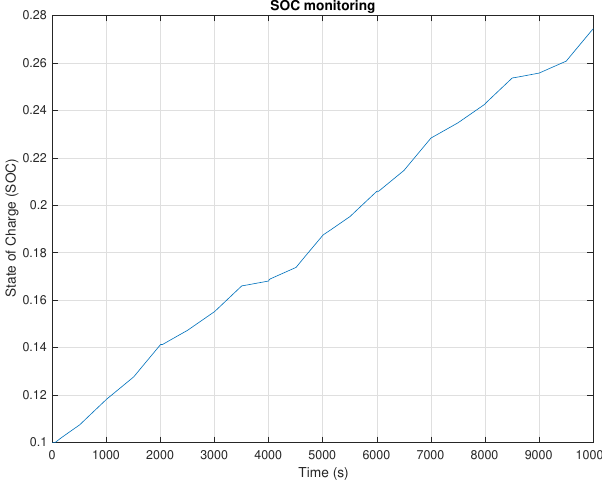
Figure 26. SOC profile during the